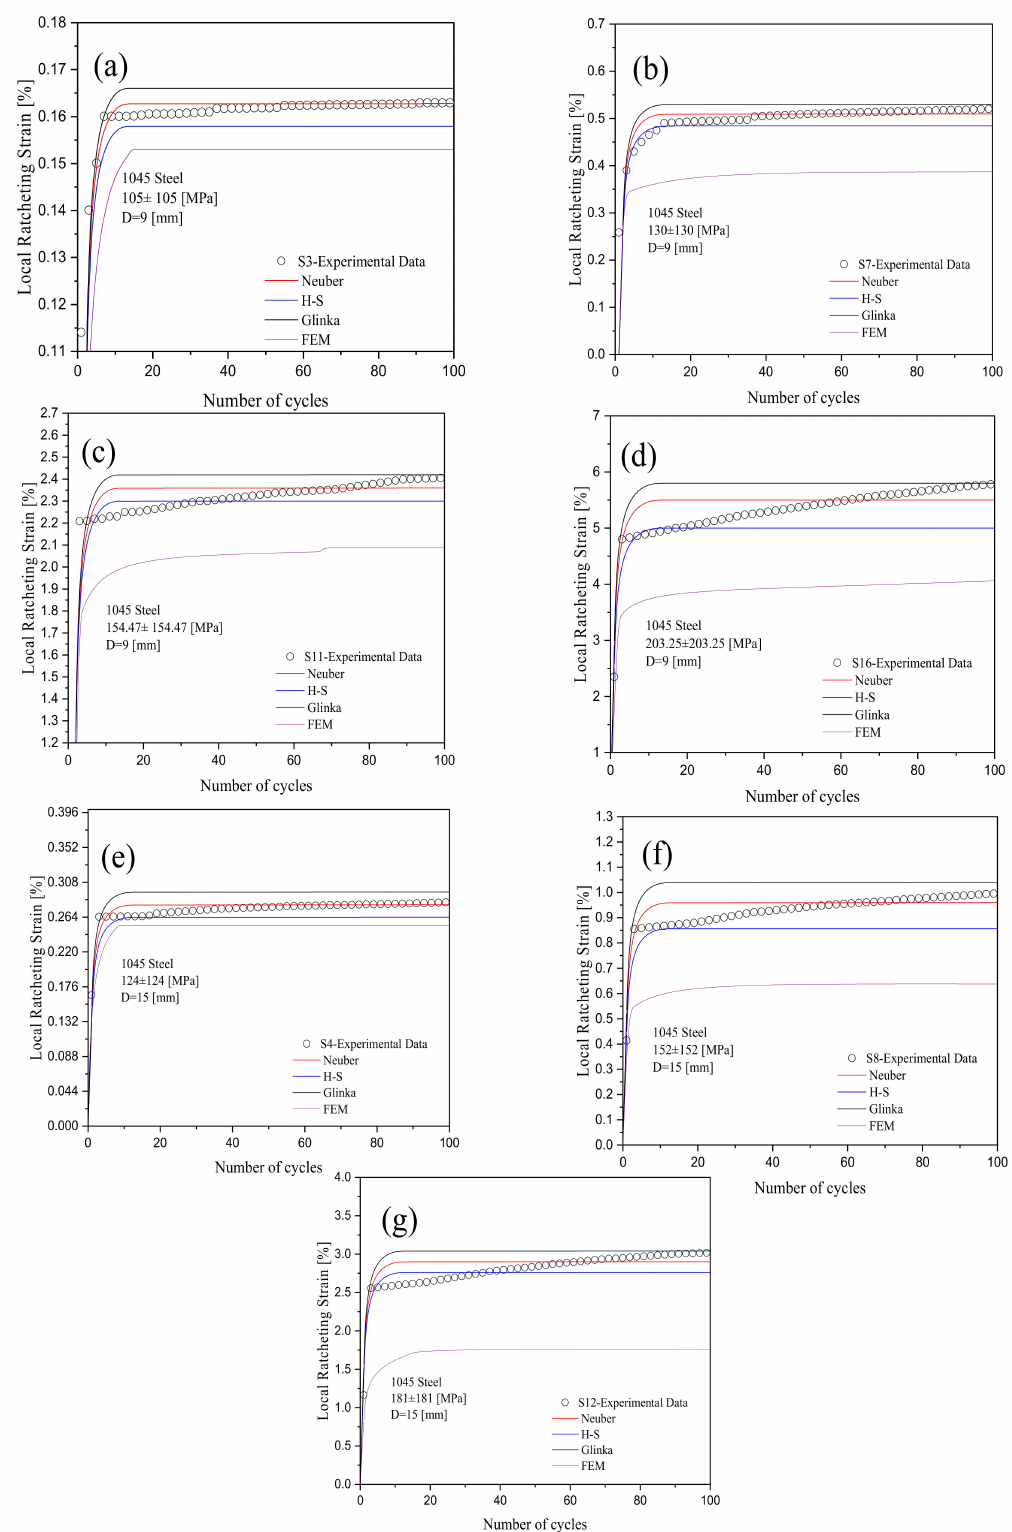
Figure 9. Predicted ratcheting curves using three different models coupled with the A-V hardening rule versus experimental ratcheting data for 1045 steel notched specimens undergoing various stress levels of ( a ) 105 ± 105 MPa with D = 9 mm, ( b ) 130 ± 130 MPa with D = 9 mm, ( c ) 155 ± 155 MPa with D = 9 mm, ( d ) 203 ± 203 MPa with D = 9 mm, ( e ) 124 ± 124 MPa with D = 15 mm, ( f ) 152 ± 152 MPa with D = 15 mm, ( g ) 181 ± 181 MPa with D = 15